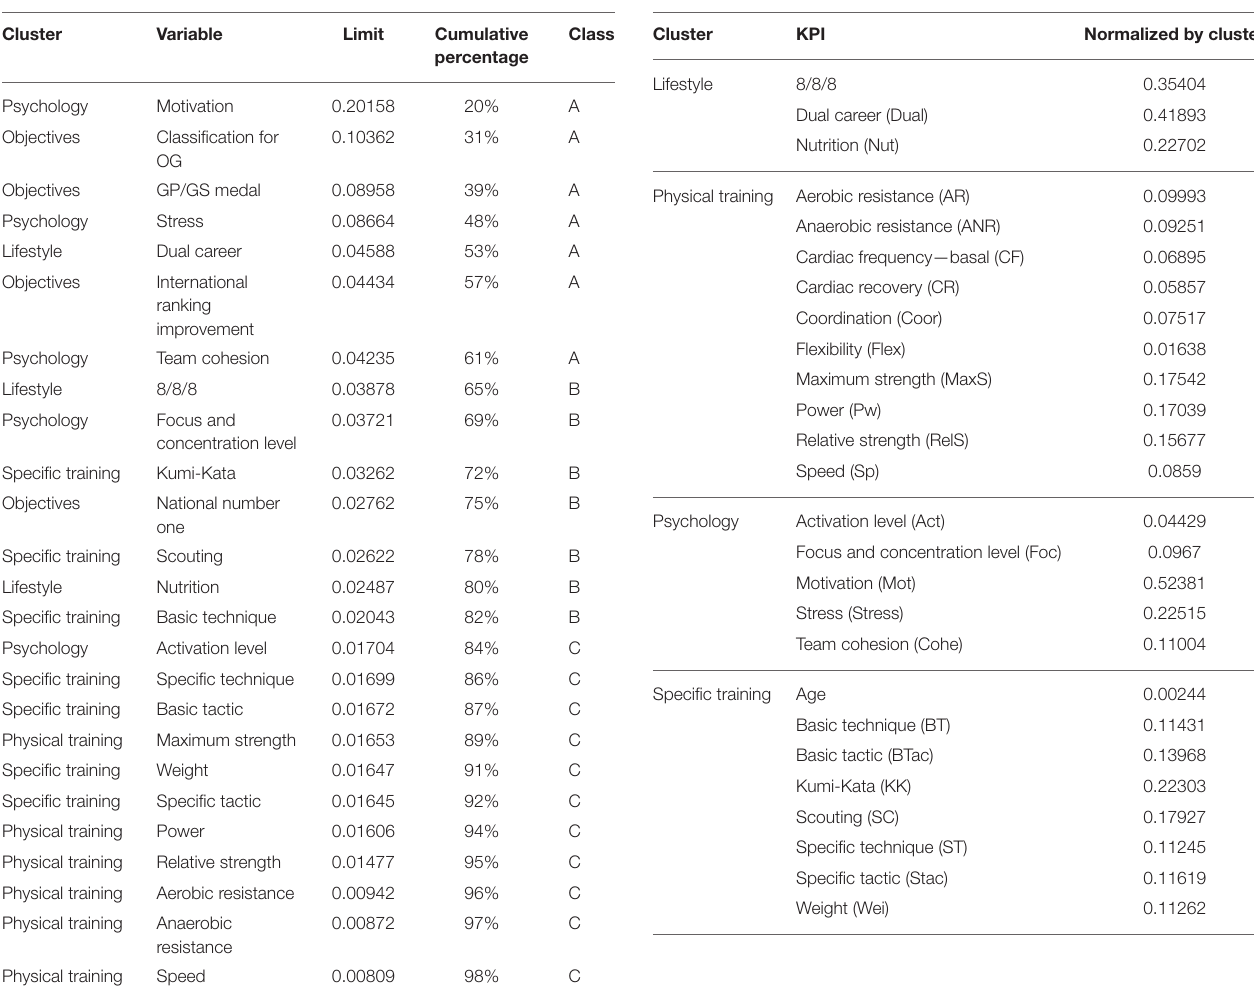
TABLE 5 | Limit matrix and ABC analysis. TABLE 6 | Normalized-by-cluster